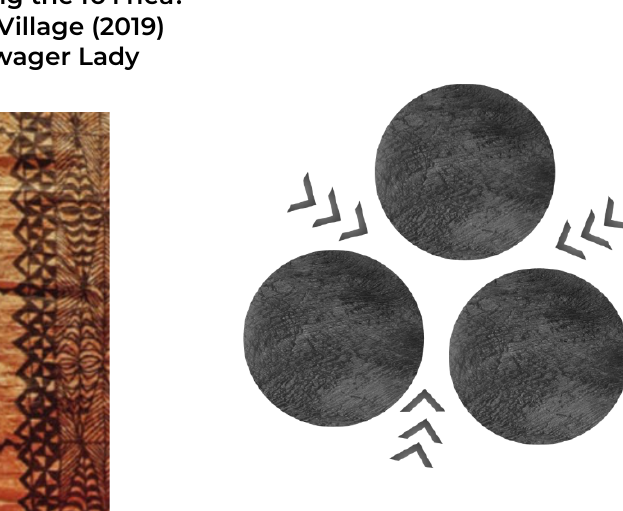
Figure 1. Ngatu Tahina, Hangatonu depicting various kupesi (designs) including the fo’i hea.